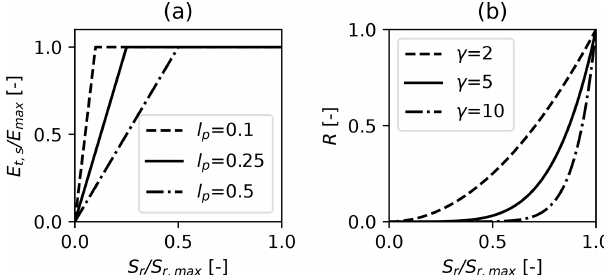
Figure 4. Relationships between the saturation of the root zone ( S r /S r , max ) and the fraction of the potential evaporation that is evaporated through the root zone ( E t , s /E max ) (a) , and the drainage ( R ) from the root zone reservoir (b) . The saturated hydraulic con- ductivity is set to k s = 1mmd − 1